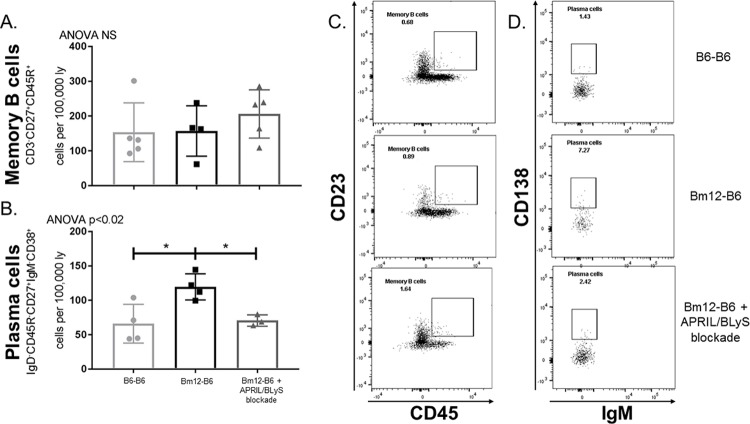
Plasma cells, but not memory B cells, were significantly decreased with APRIL/BLyS blockade.Flow cytometry was used to assess long-lived B cell populations in spleen. (A) Graph shows number of cells per 100,000 lymphocytes. Memory B cells were defined as CD3-CD27+CD45R+. (B) Graph shows number of plasma cells per 100,000 cells collected. Plasma cells were defined as CD3-IgD-CD45R-CD27+IgM-CD38+. (C) Representative flow cytometry data of memory B and plasma cells by group. Number shown represents percentage of total cells in gate. *p<0.05.